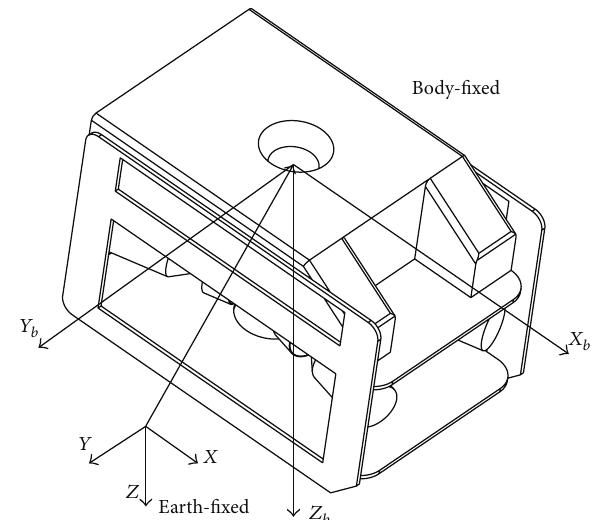
Figure 1: Earth-fixed and body-fixed frame.